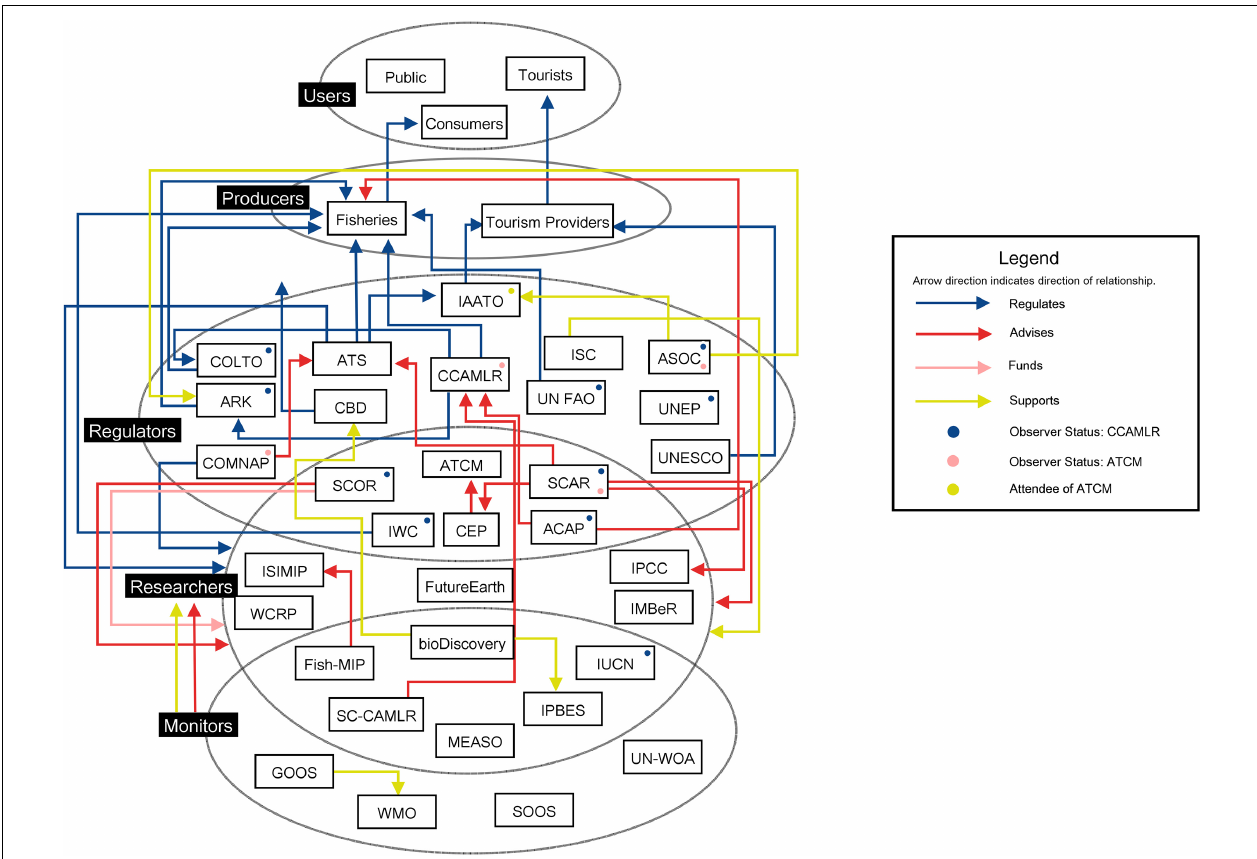
FIGURE 2 | Network visualization of relationships between key stakeholders in Southern Ocean ecosystem management, grouped by their functional role in ecosystem management as per methods. Some individual stakeholders do not have direct connections to other stakeholders, although their parent stakeholder groups, labeled as black text boxes, are connected with other stakeholder groups or with individual